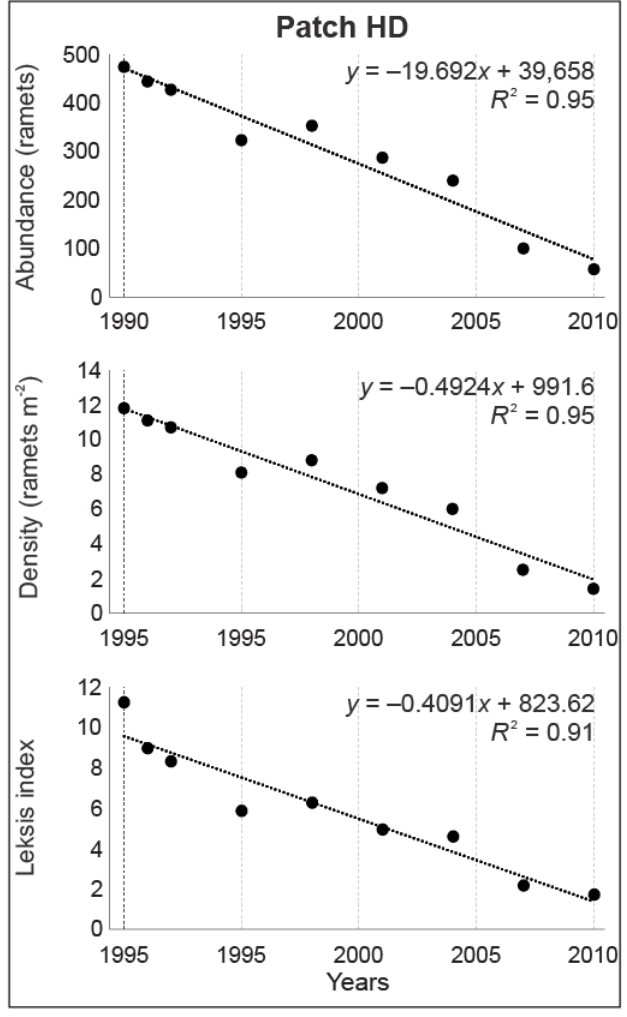
Figure 7 Changes of values and linear regression for abundance, density, and Leksis’ index of the Senecio umbrosus population within patch